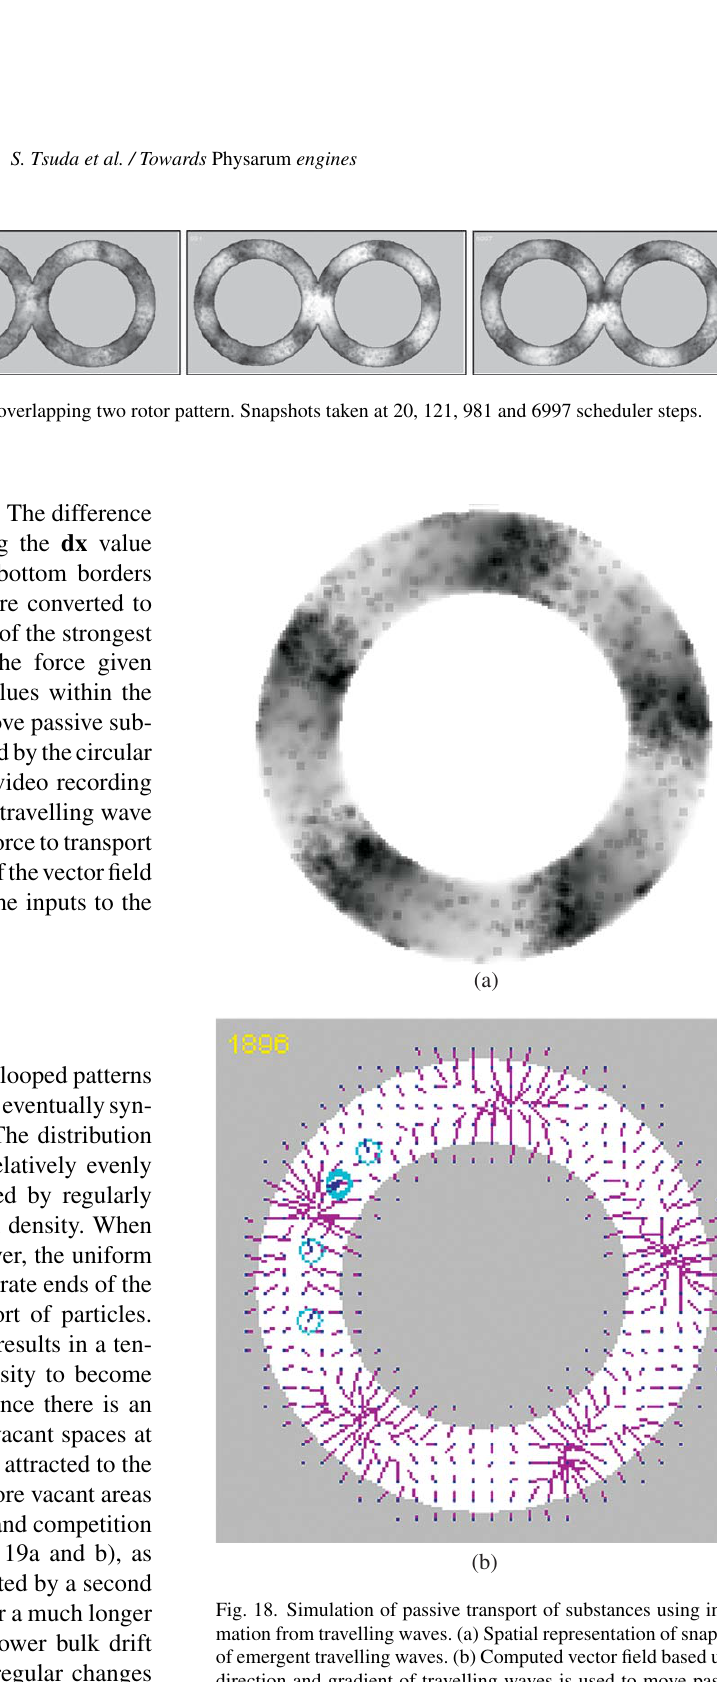
Fig. 18. Simulation of passive transport of substances using infor- mation from travelling waves. (a) Spatial representation of snapshot of emergent travelling waves. (b) Computed vector field based upon direction and gradient of travelling waves is used to move passive objects (circular